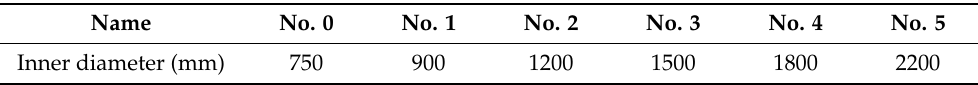
Table 1. Types of manholes in practical use in Japan (Japan Sewerage Association).